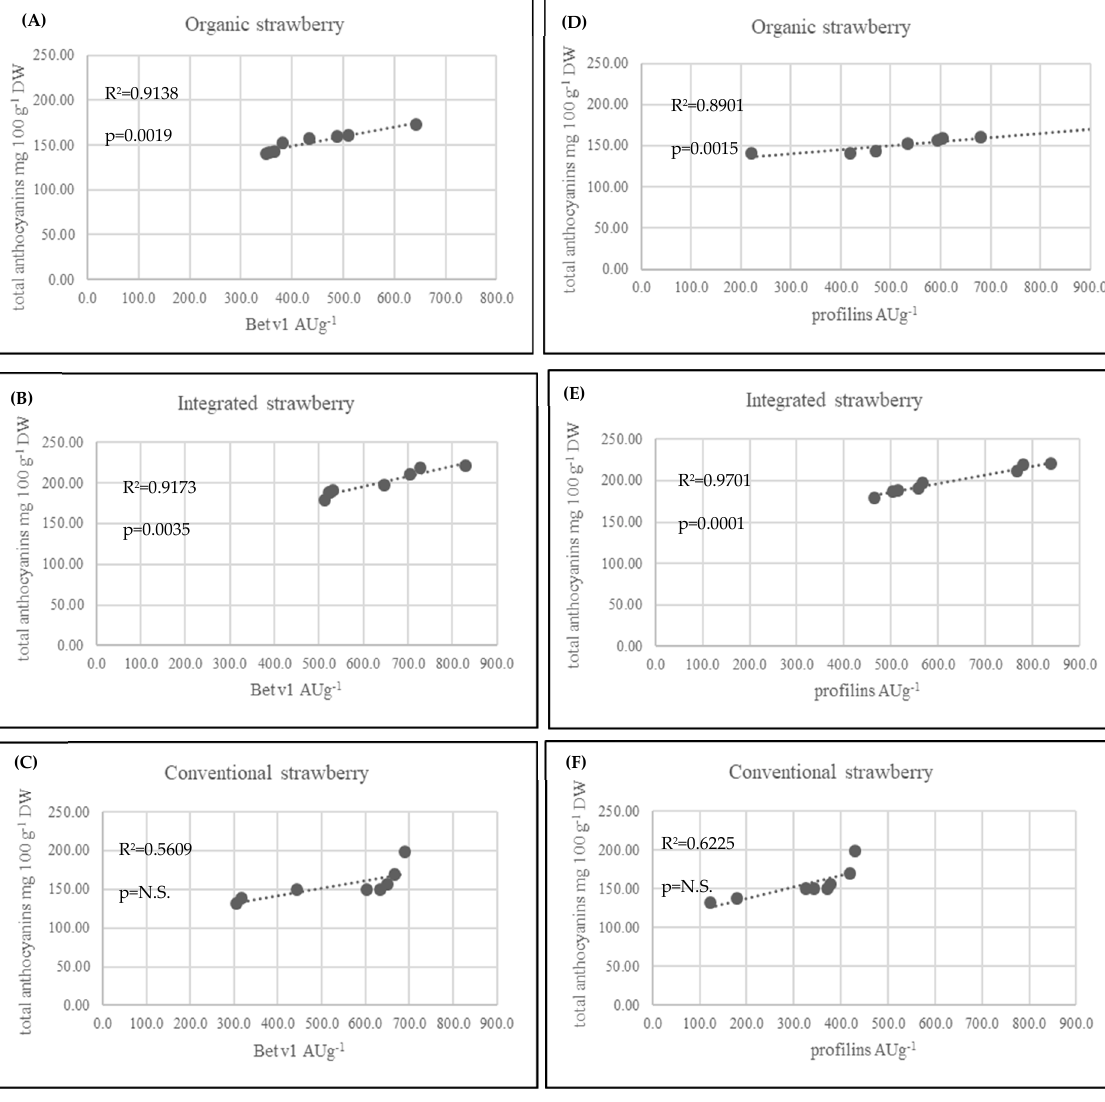
Figure 5. Linear correlation (Pearson’s coefficient R 2 ) between allergenic proteins profilins, Bet v 1 and total anthocyanins in strawberry fruits from three cultivation systems.